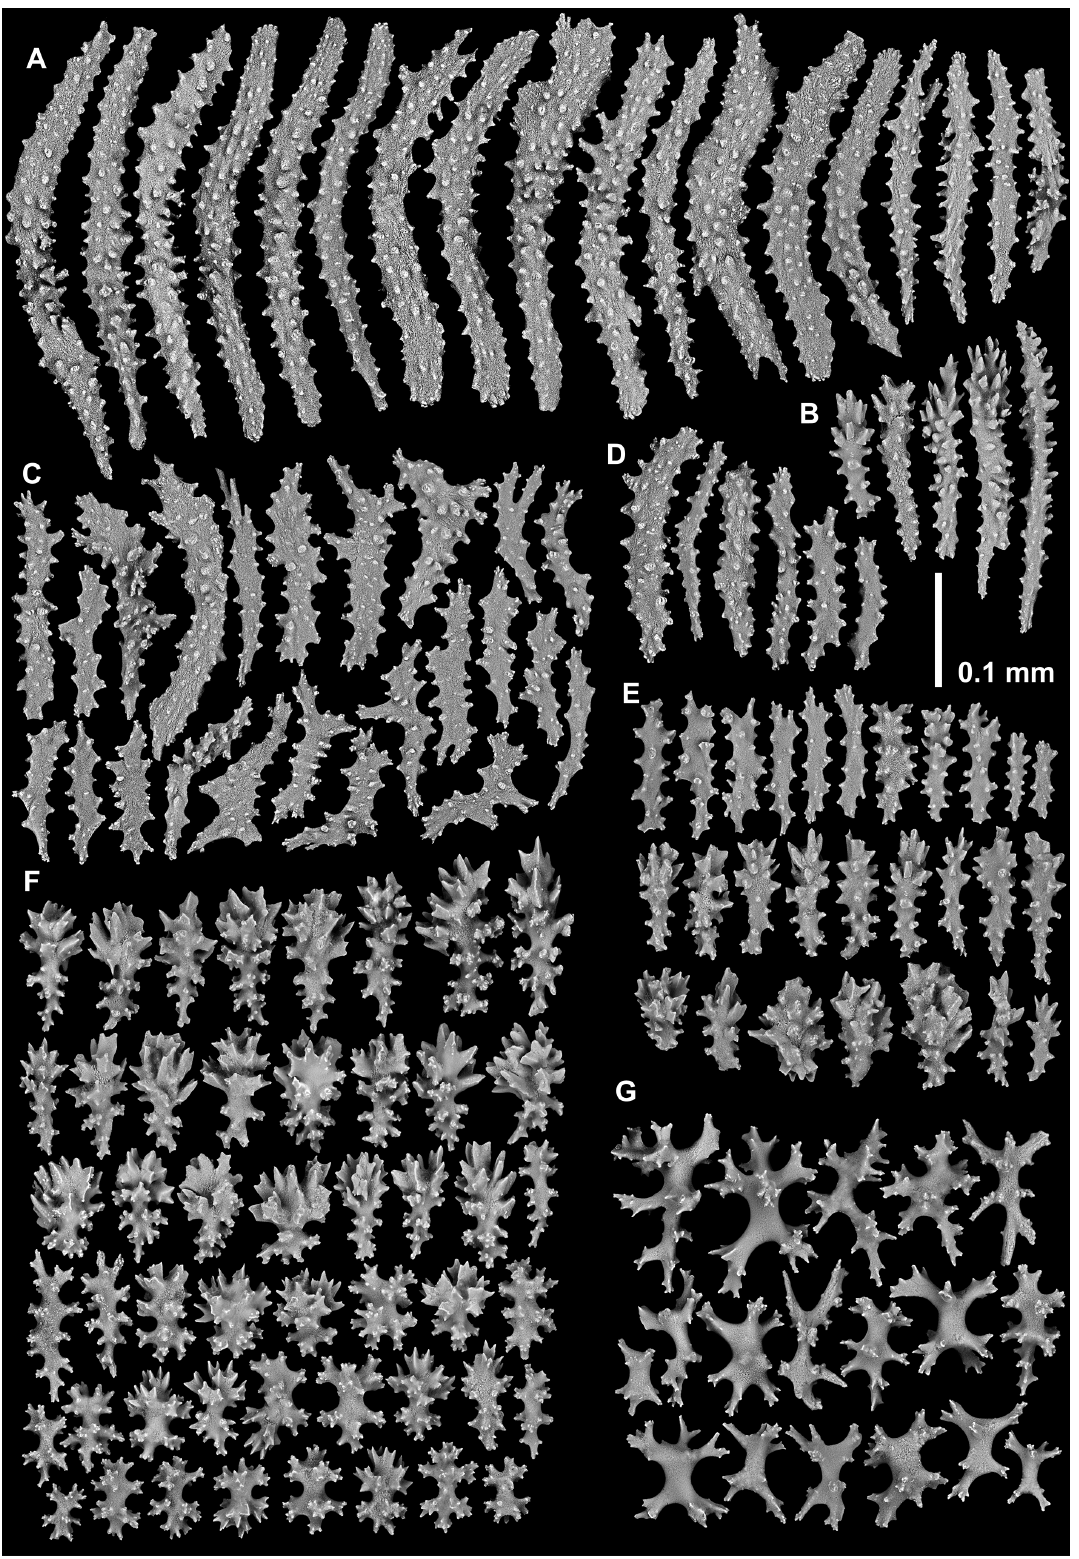
Fig. 12. Kotatea kapotaiora gen. et sp. nov., holotype (NIWA 3974), SEMs of sclerites. A . Collaret and points. B . Distal points. C . Tentacles. D . Polyp neck. E . Polyp mound. F . Lobe surface. G . Lobe